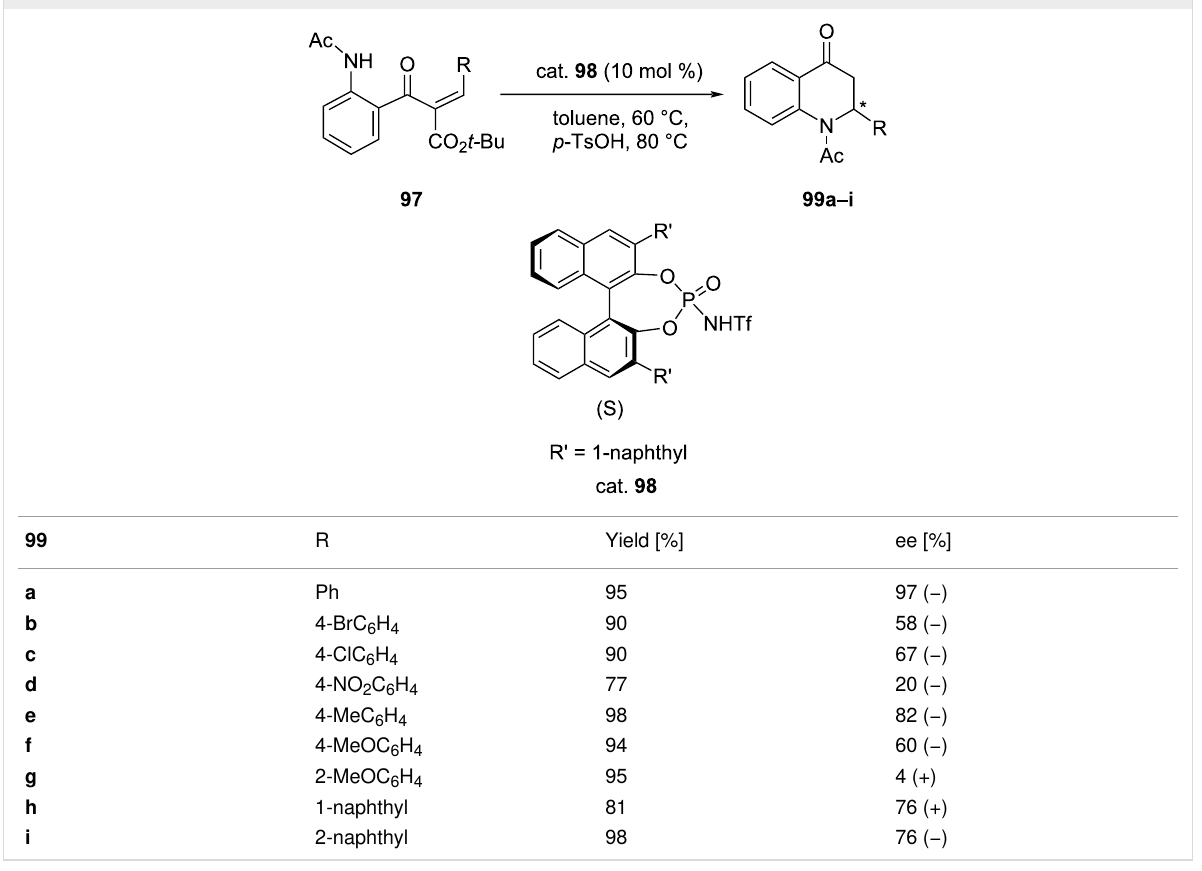
Table 22: Intramolecular aza-Michael addition reaction catalyzed by chiral N -triflylphosphoramide.